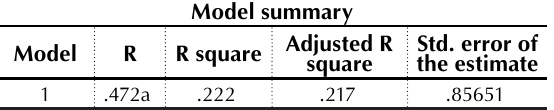
Table 6. Regression analysis between social media marketing strategies and functional